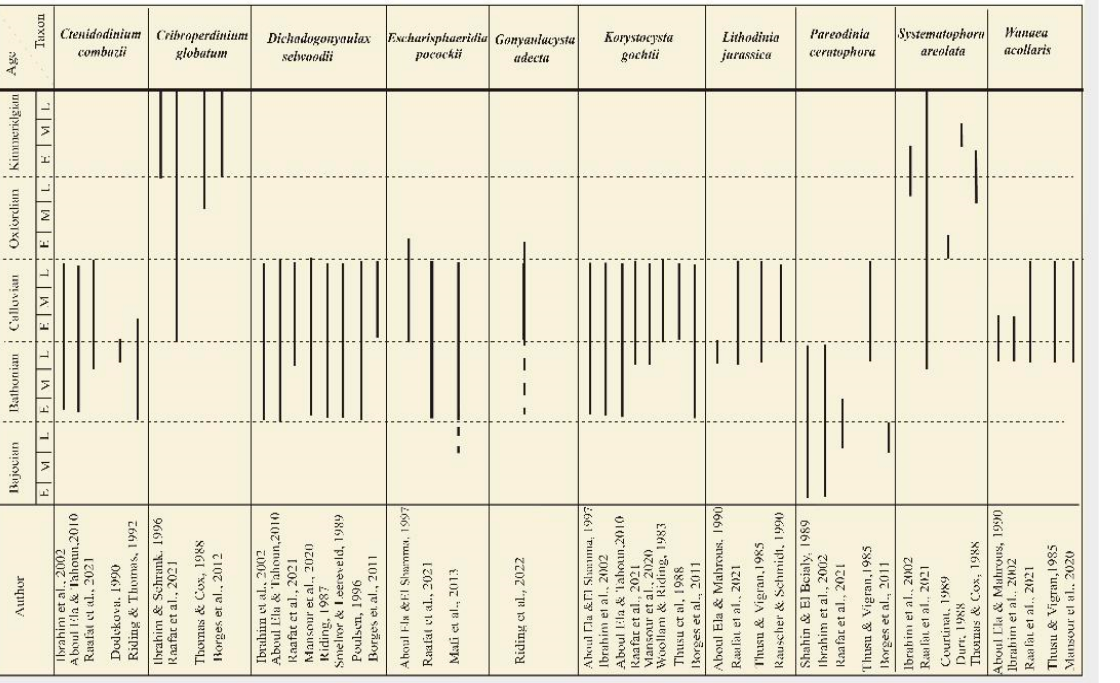
Figure 9. Distribution range chart of the most important age-diagnostic taxa recovered from the Khatatba Formation in the studied wells and their age ranges in comparison to published works